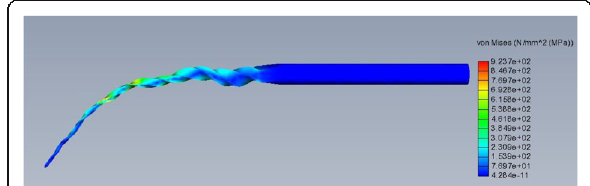
Fig. 5 Stress distribution during bending of ProTaper NEXT